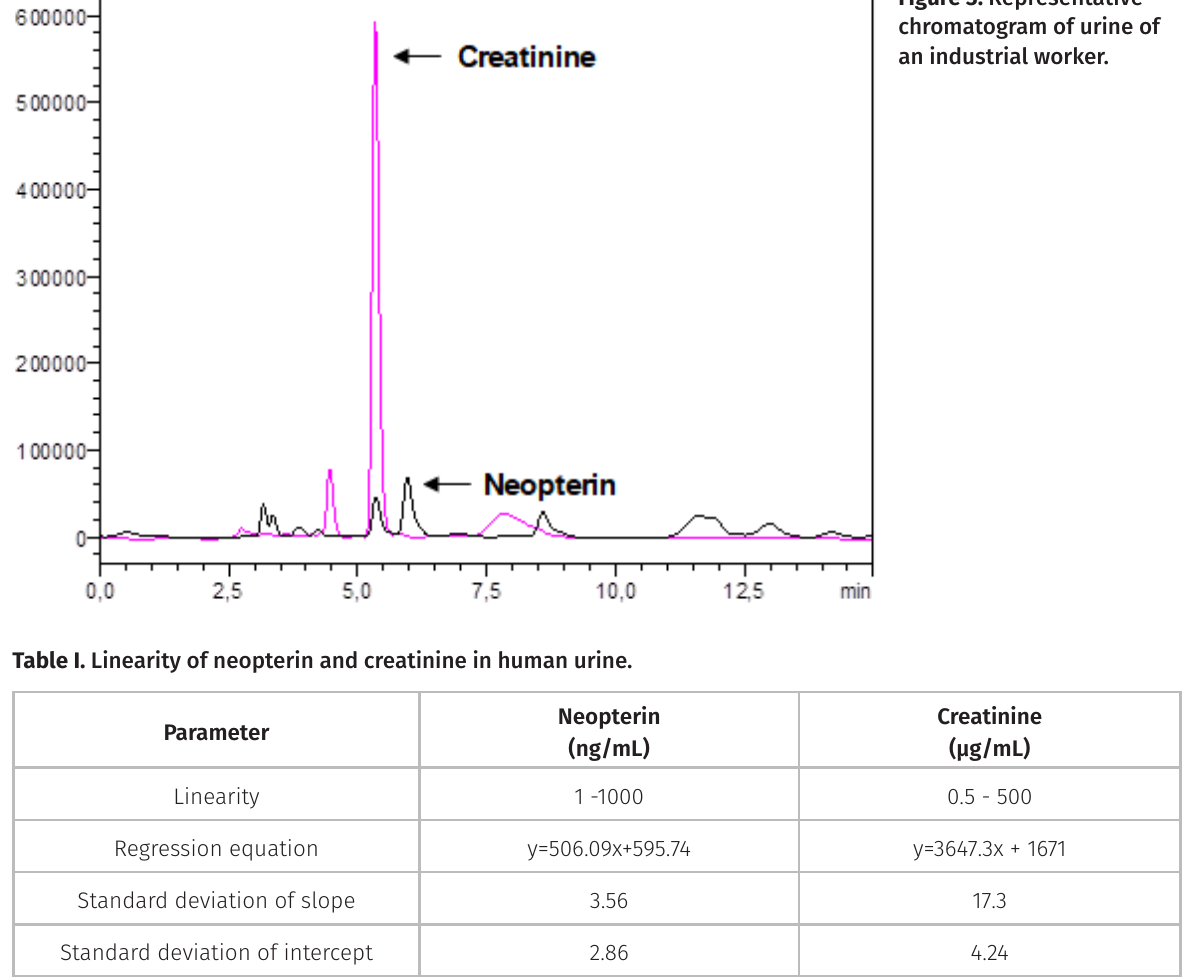
Figure 3. Representative chromatogram of urine of an industrial worker.